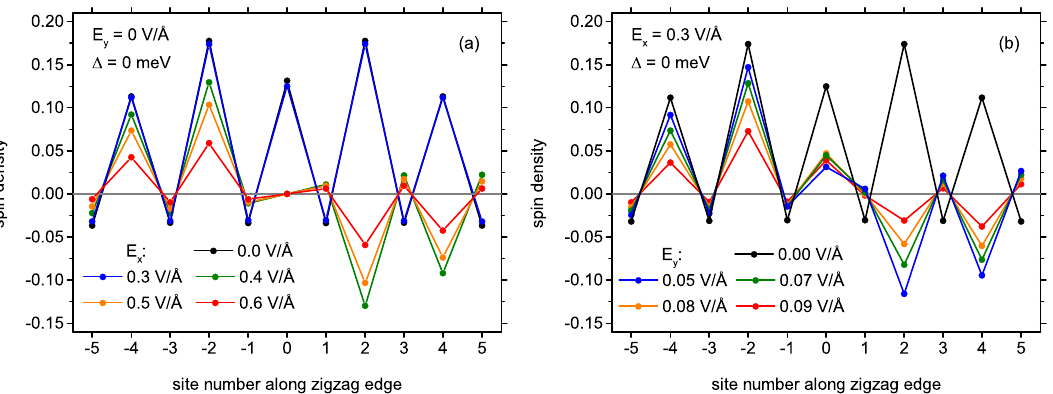
Figure 8. Spin distribution along the longest zigzag edge of the nanostructure in the absence of the exchange energy, for electric field E y = 0 and a few selected values of E x ( a ) and for electric field E x = 0.3 V/Å and a few selected values of E y ( b ). Lines are guides to eyes